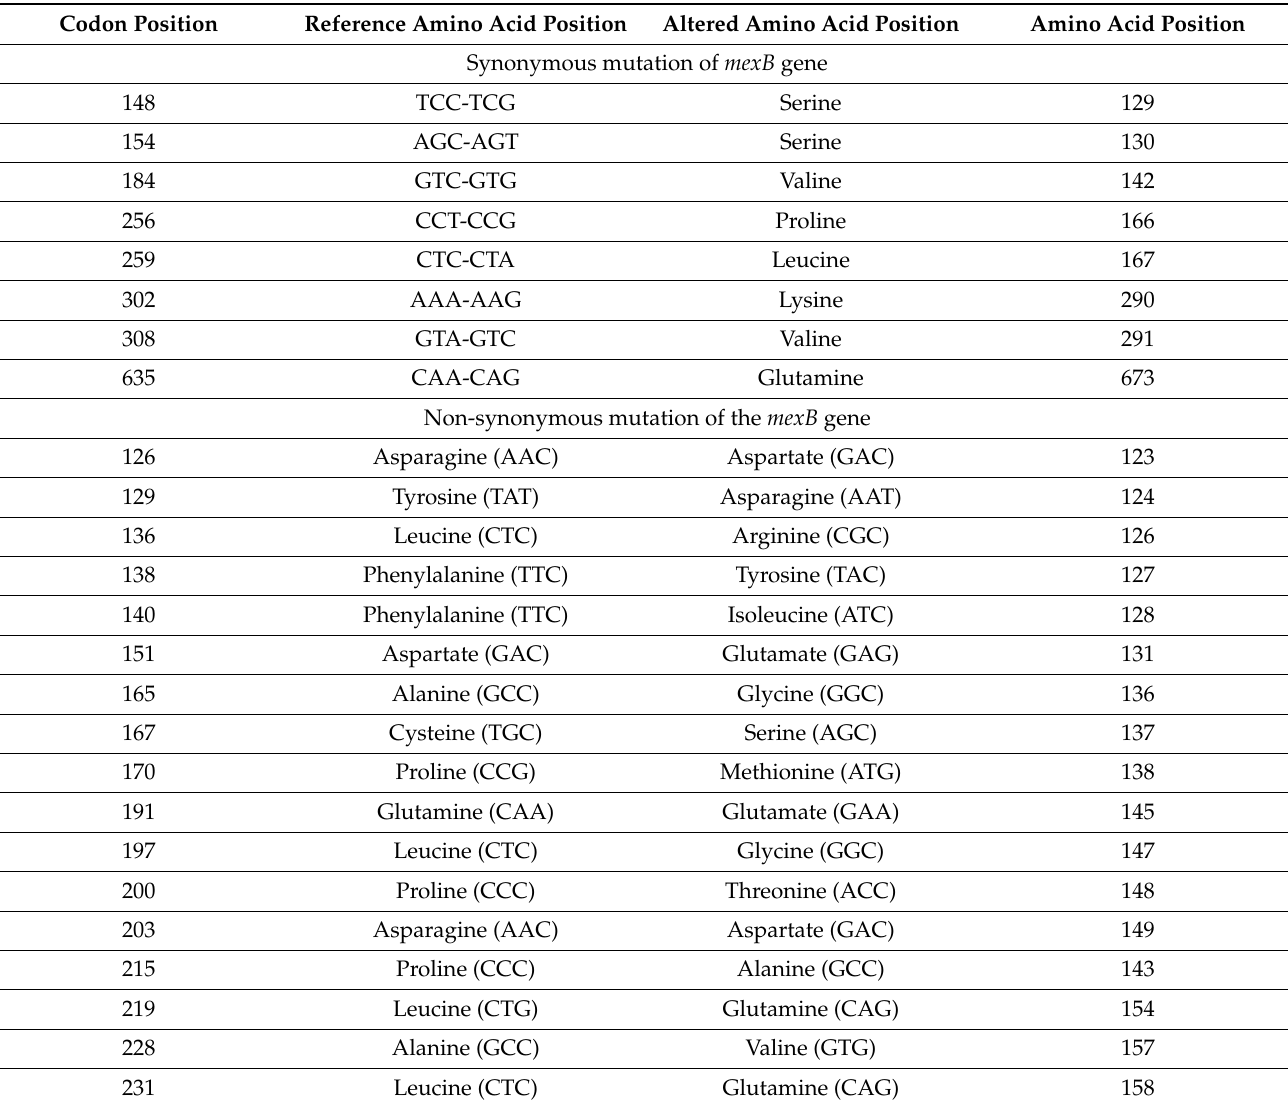
Table 9. Synonymous and non-synonymous mutations of the mexB